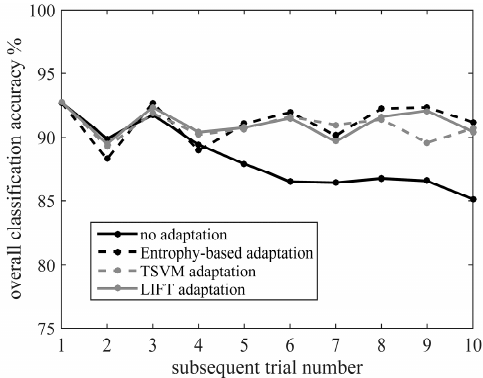
Figure 6. Classification accuracy over time when using three different adaptation strategies and a non-adaptive classification scheme. The accuracy curves were generated from the experimental data collected from TF01.